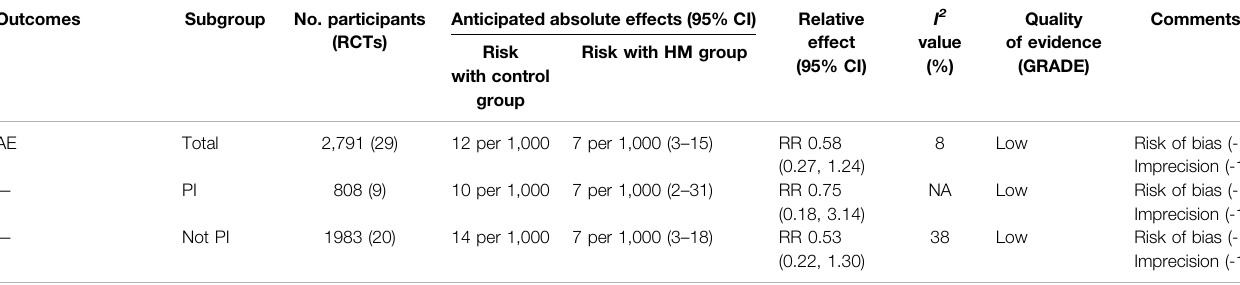
TABLE 1 | ( Continued ) Results of meta-analysis and summary of fi